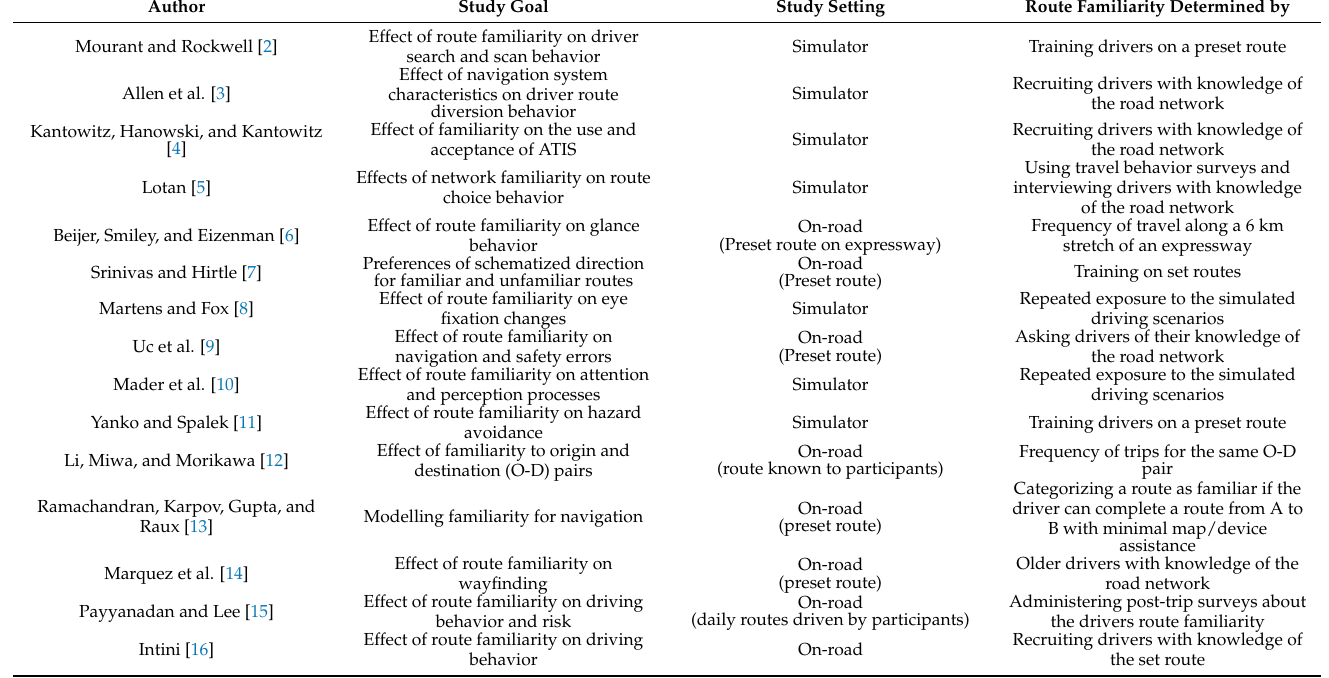
Table 1. Commonly used approaches for capturing route familiarity in simulator and on-road